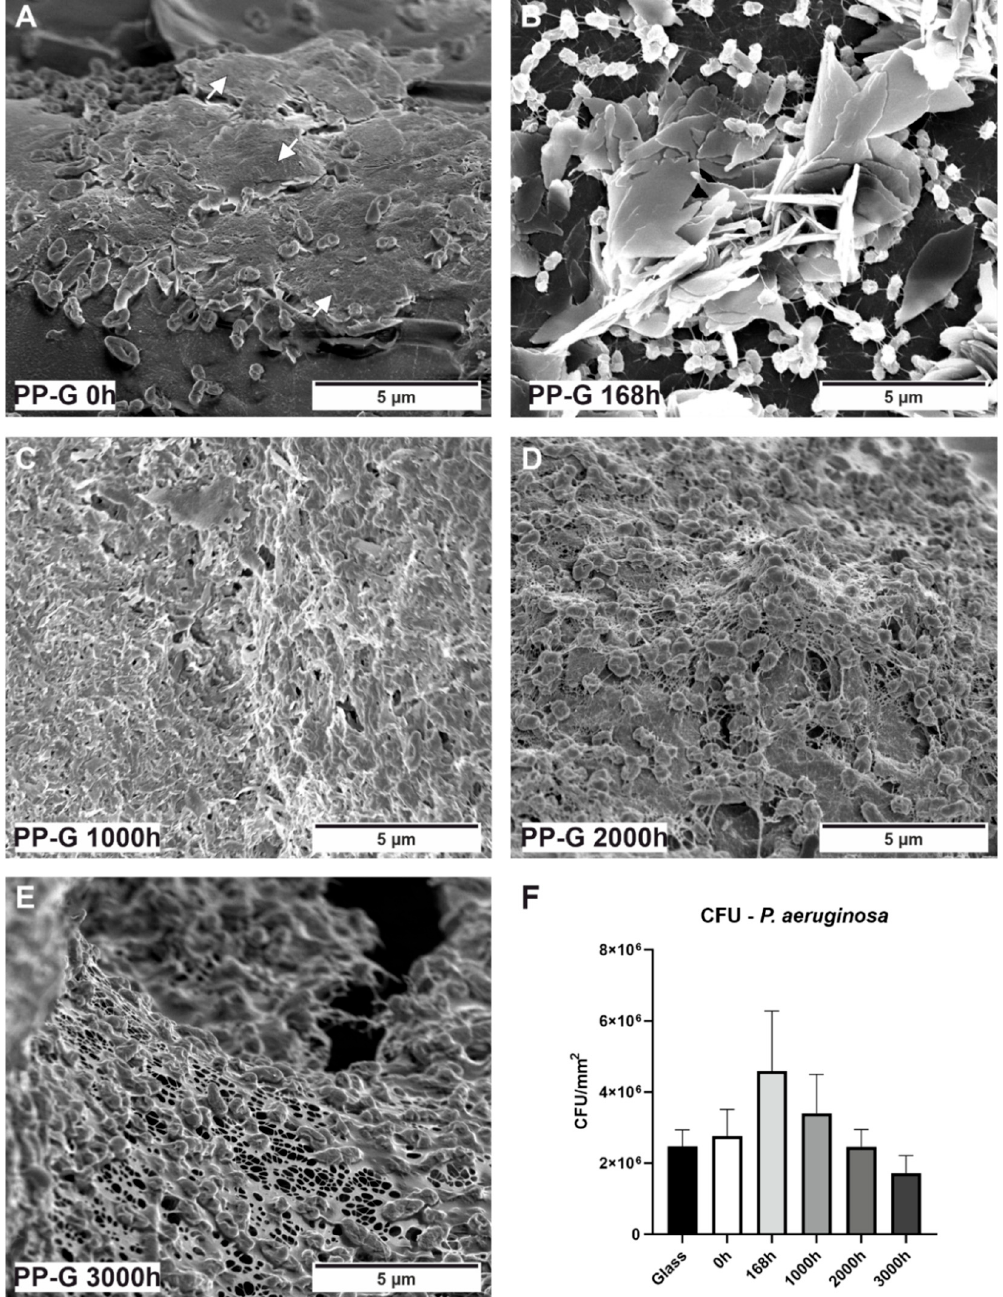
Figure 5. Influence of aged polypropylene samples on bacterial attachment. SEM image of ( A ) P. aeruginosa attached to PP-G after 0 h with EPS indicated by white arrows, ( B ) after 168 h with visible EBS, ( C ) after 1000 h, ( D ) after 2000 h, and ( E ) after 3000 h. ( F ) CFU assay results quantifying the attached P. aeruginosa , compared to the reference glass sample. Mean ± standard error of the mean are shown.